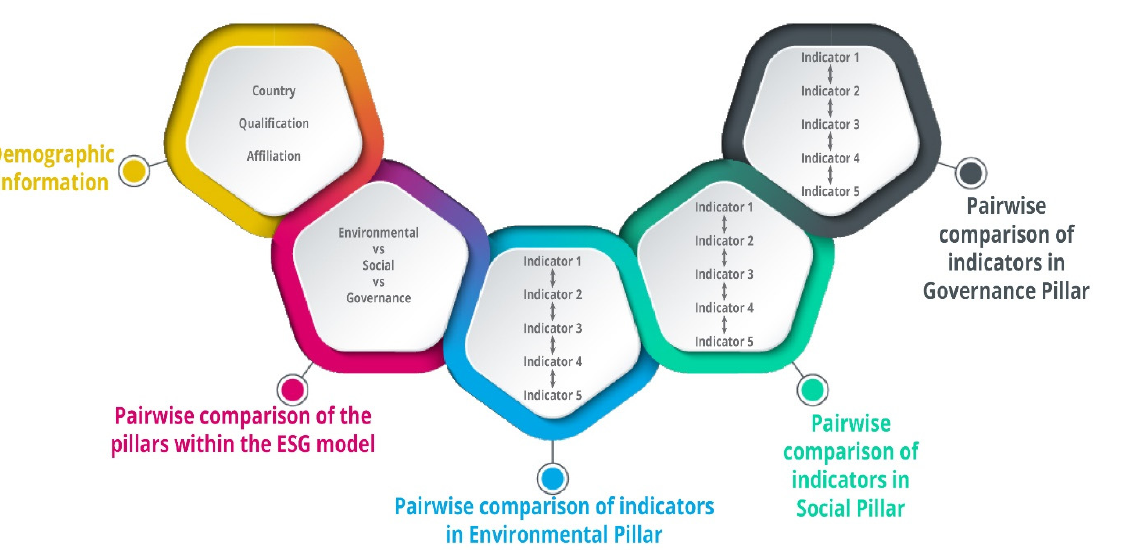
before the analytical hierarchical process, which is discussed